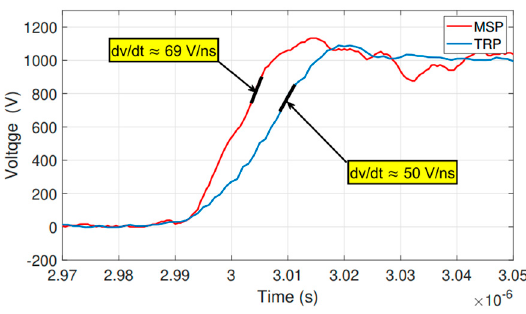
Figure 18. Measured dv/dt for TRP and MSPs.